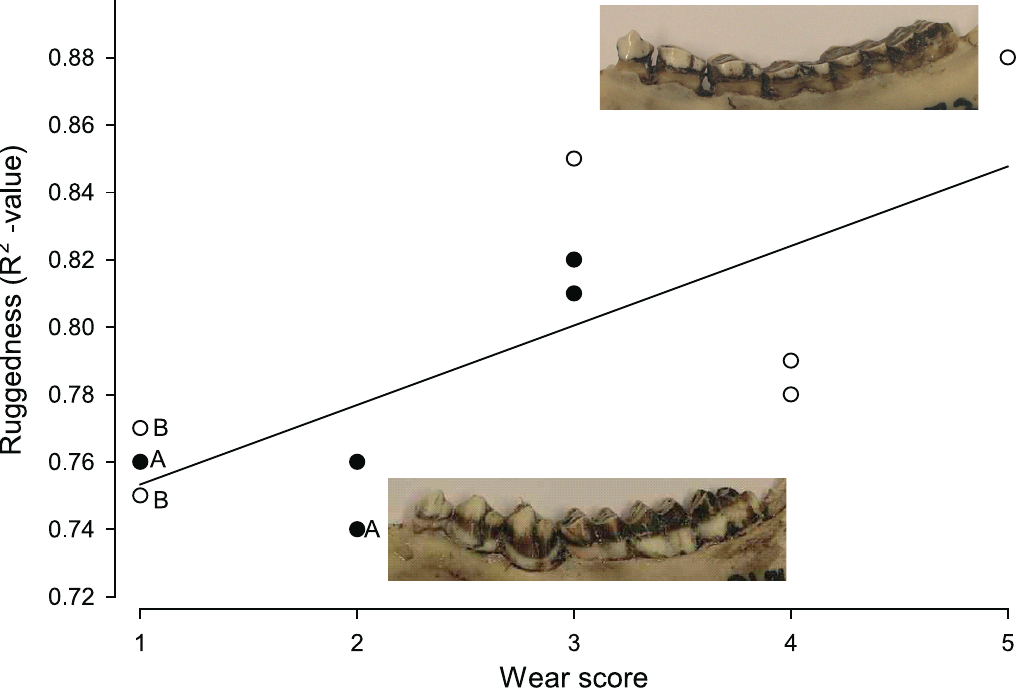
Fig. 3. Fit between R 2 -values (index of ruggedness, after fitting a second order polynomial), with subjective scores of photographs of teeth (1 = little worn down, 5 = much worn down), shown by the solid line. Filled circles rep - resent males, open circles represent females. The upper picture shows the most worn down tooth-line (highest R 2 -values), while the lower shows the tooth-line of the least worn specimen (lowest R 2 -value). Similar letters indicate mandibles of the same